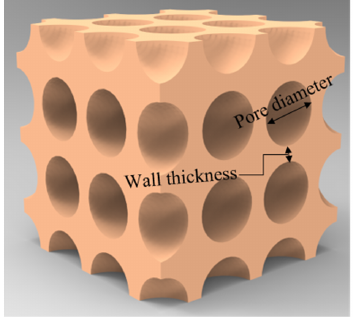
Figure 2. Schematic of the sphere foam model for the closed-cell copper foam.